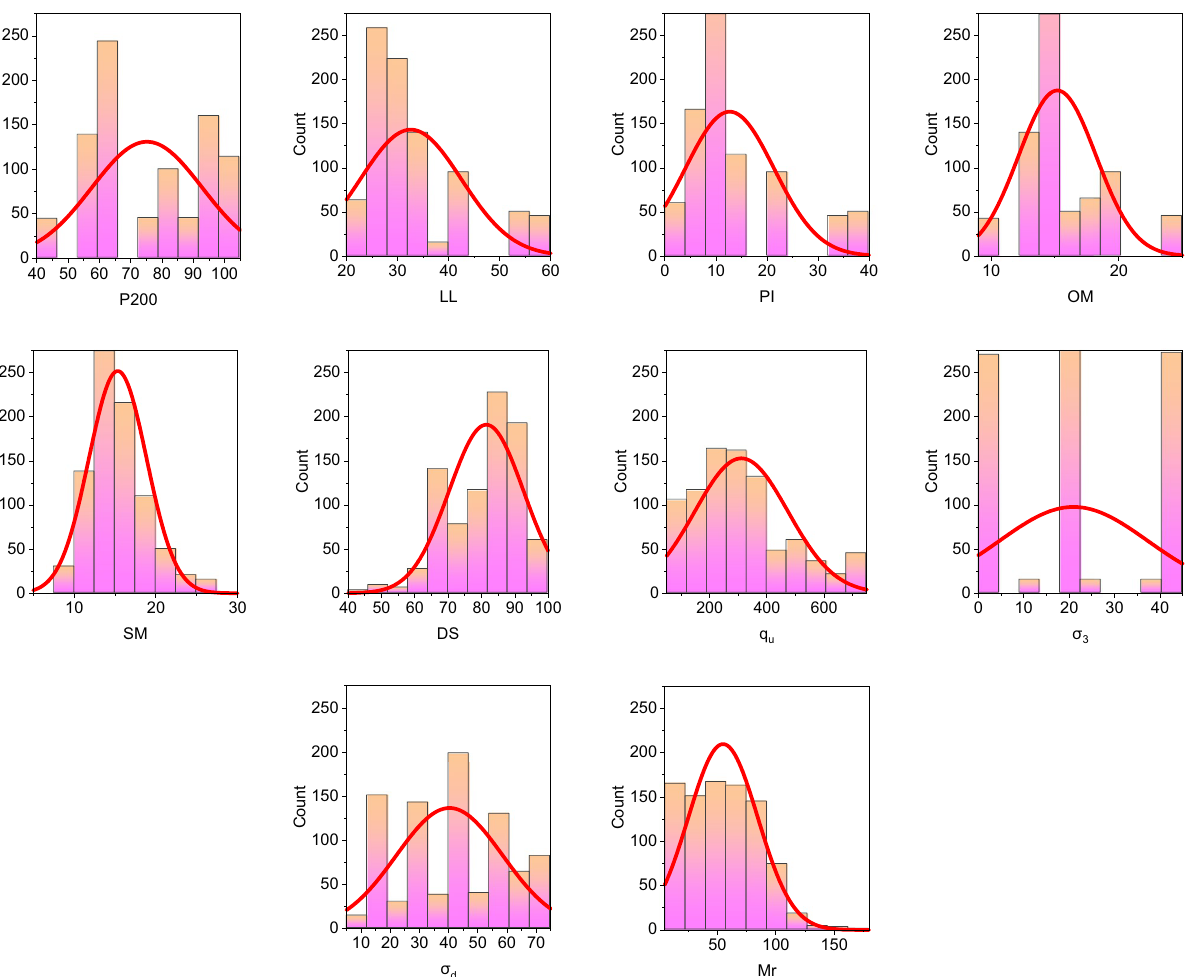
Figure 2. Histogram and normal distribution of datasets of subgrade soil